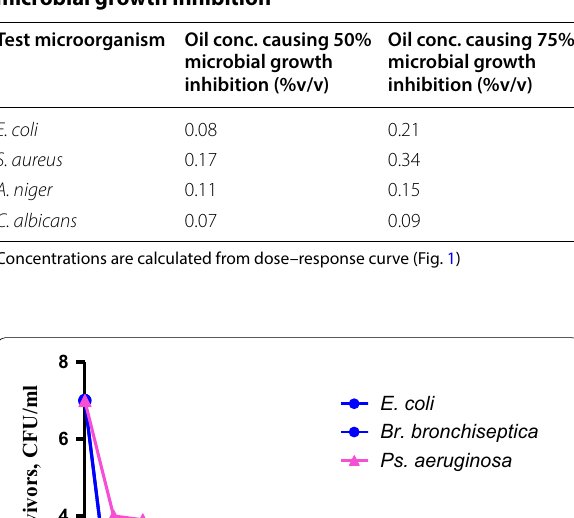
Table 4 Concentrations of OV EO causing 50% and 75% microbial growth inhibition